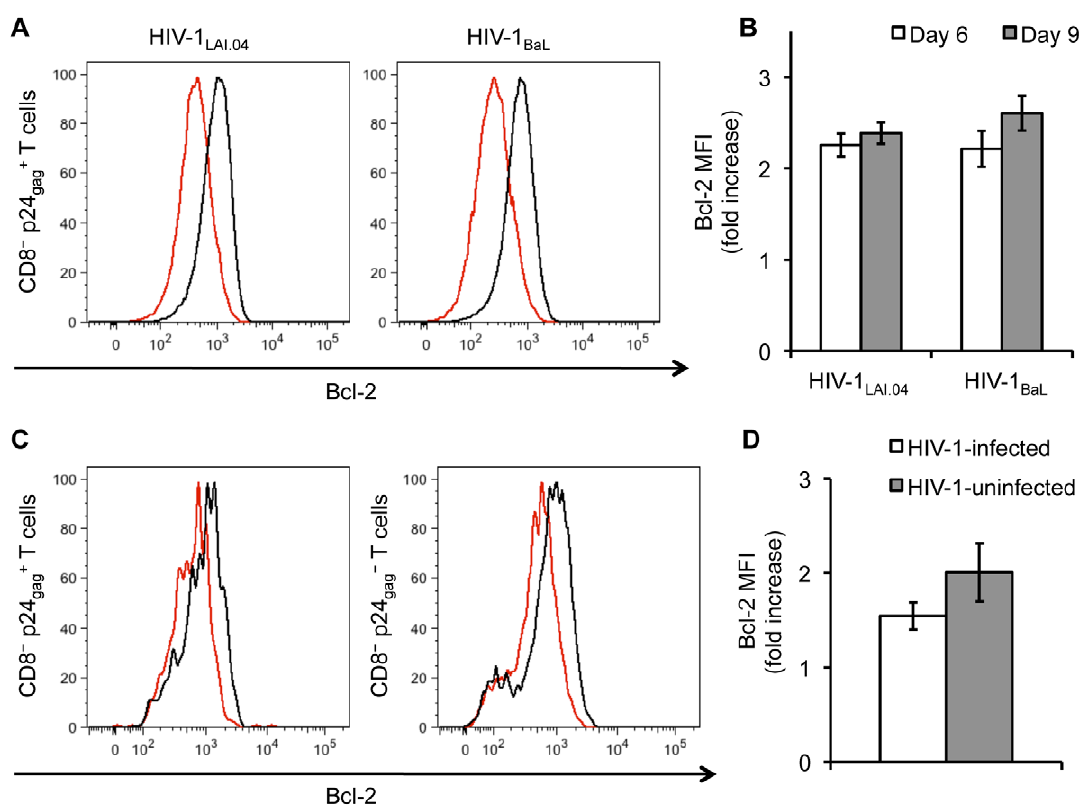
Figure 6. IL-7 up-regulates the expression of Bcl-2. ( A ) Presented are the expression levels of the anti-apoptotic protein Bcl-2 in HIV-1-infected CD4 + (CD8 2 p24 gag + ) T cells isolated from lymphoid tissue blocks infected with HIV-1 LAI.04 or HIV-1 BaL and treated with IL-7 25 ng/mL (black line) vs. infected untreated tissue blocks (red line) from a representative donor on day 9 post infection. The amount of Bcl-2 is expressed as median fluorescence intensity (MFI) value. ( B ) Presented are the average increases in Bcl-2 expression in HIV-1-infected CD4 + T cells isolated from lymphoid tissue blocks infected with HIV-1 LAI.04 ( n =8) or HIV-1 BaL ( n =6) and treated with IL-7 25 ng/mL compared with infected untreated donor-matched tissue blocks (means 6 s.e.m.). ( C ) Presented are the expression levels of Bcl-2 in HIV-1-infected and -uninfected (CD8 2 p24 gag 2 ) CD4 + T cells isolated from cervico-vaginal tissue blocks infected with HIV-1 BaL and treated with IL-7 (black line) vs. untreated tissue blocks (red line) from a representative donor on day 9 post infection. ( D ) Presented are the average increases in Bcl-2 expression in HIV-1-infected and -uninfected CD4 + T cells isolated from cervico-vaginal tissue blocks infected with HIV-1 BaL and treated with IL-7 25 ng/mL compared with infected untreated donor-matched tissue blocks (means 6 s.e.m., n =5).